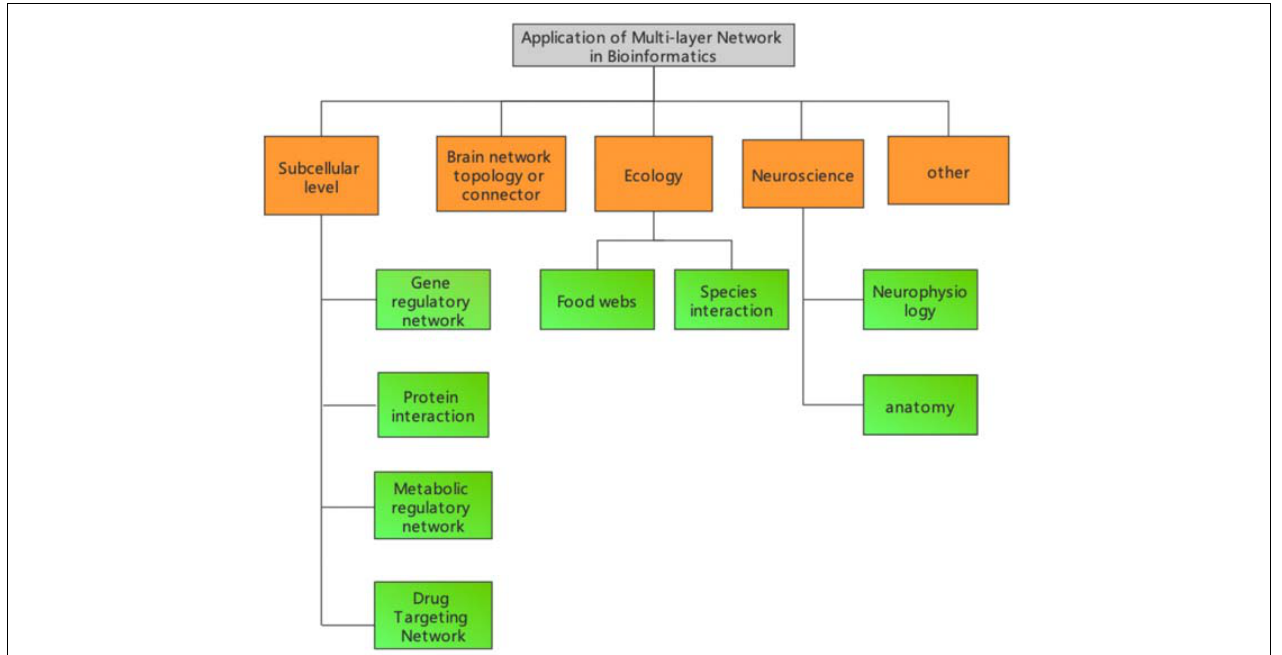
FIGURE 1 | Multilayer network application area framework in